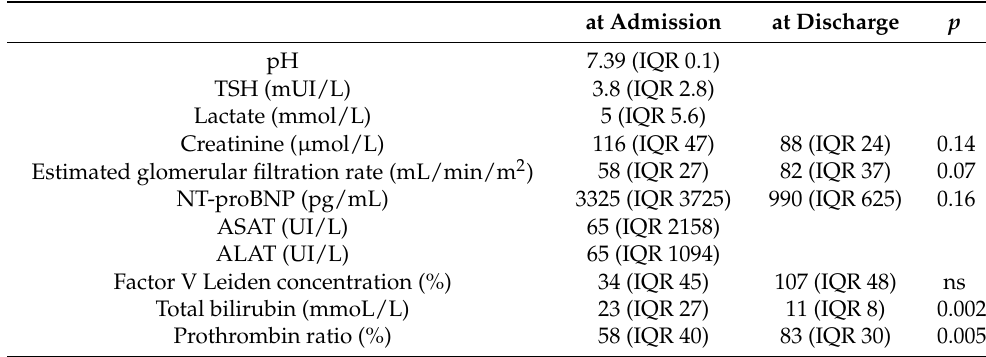
Table 2. Biological characteristics of included patients and evolution from admission to discharge (results in median and